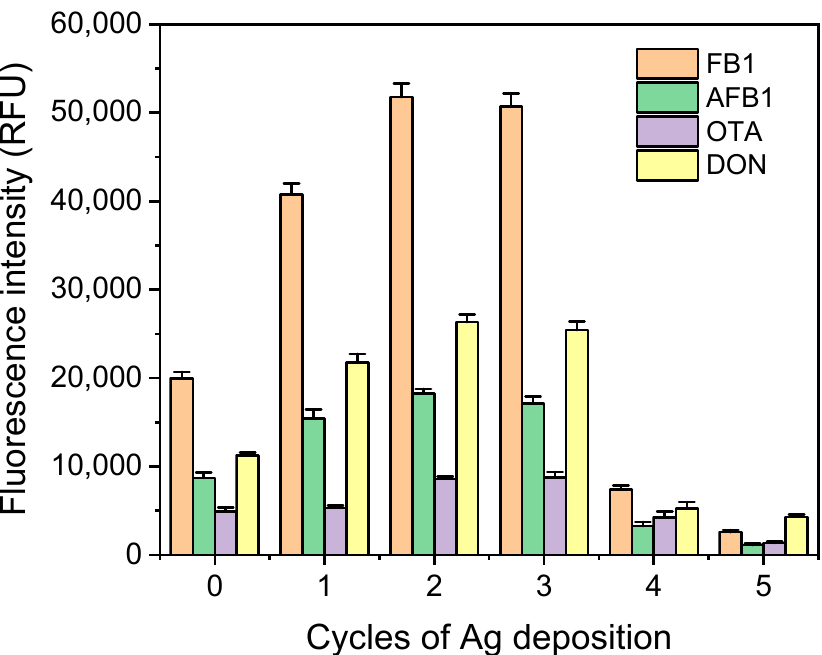
Figure 3. Fluorescence intensity values corresponding to zero calibrators of each one of the four targeted mycotoxins obtained with 3D micro-nanostructured poly(methyl methacrylate) (PMMA) slides non-treated with silver enhancement solution (column group 0) or treated with silver enhancement solution for 1 to 5 consecutive times (columns groups 1 to 5, respectively). The column designation is as follows: orange fumonisin B1 (FB1); green aflatoxin B1 (AFB1); purple ochratoxin A (OTA); yellow deoxynivalenol (DON). Each value is the mean of 16 spots ± SD. In addition to comparison with the 3D micro-nanostructured PMMA slides, the fluo- rescence intensity values obtained for the zero calibrators of the four targeted mycotoxins, i.e., the highest signal obtained for each assay in absence of analyte in a competitive im- munoassay format, were compared using the same scanning conditions to those obtained using glass slides modified with APTES without further processing, as well as after the application of 2 Ag deposition cycles. Moreover, the fluorescence values obtained from flat PMMA slides, i.e., slides non-treated with oxygen plasma were also provided. As shown in Figure 4, the fluorescence signals intensity was significantly improved in case of APTES-modified slides for three out of the four mycotoxins, i.e., FB1, AFB1 and DON, whereas for OTA there was no any signal enhancement. On the other hand, for the PMMA slides, there was a considerable increase in the fluorescence signal obtained for the zero calibrators from the combination of micro-nanostructuring and Ag plating. More specif- ically, the zero calibrator signals of AFB1 and OTA increased by 2.8 times after oxygen plasma micro-nanostructuring and Ag plating, the DON signal increased 5.6 times, while for FB1 an increase of up to 16-times was observed compared to flat PMMA slides. Most notably, this increase in the zero calibrator signal was not accompanied by a significant increase (approx. 50% increase compared to flat PMMA) in the blank signal (blue columns in Figure 4) which corresponds to fluorescence intensity value determined from slide areas outside the spots. The blank signal is the sum of the background signal (light reflected by the substrate) and the non-specific binding of the antibodies, both primary and secondary, at the areas outside the